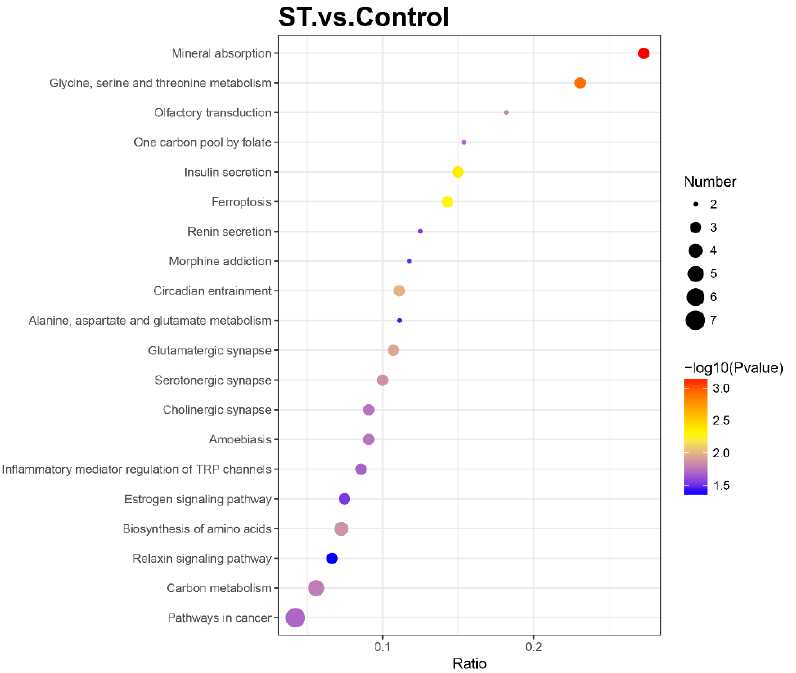
Figure 4. Bubble chart of Kyoto Encyclopaedia of Genes and Genomes (KEGG) enrichment analysis with a p value ≤ 0.05. The horizontal axis ratio represents the ratio of differential protein numbers and total numbers identified in this pathway. The colour scales indicate the p values of the t test, and red represents a higher statistical significance. The sizes of the circles are related to the number of DEPs enriched in each pathway.